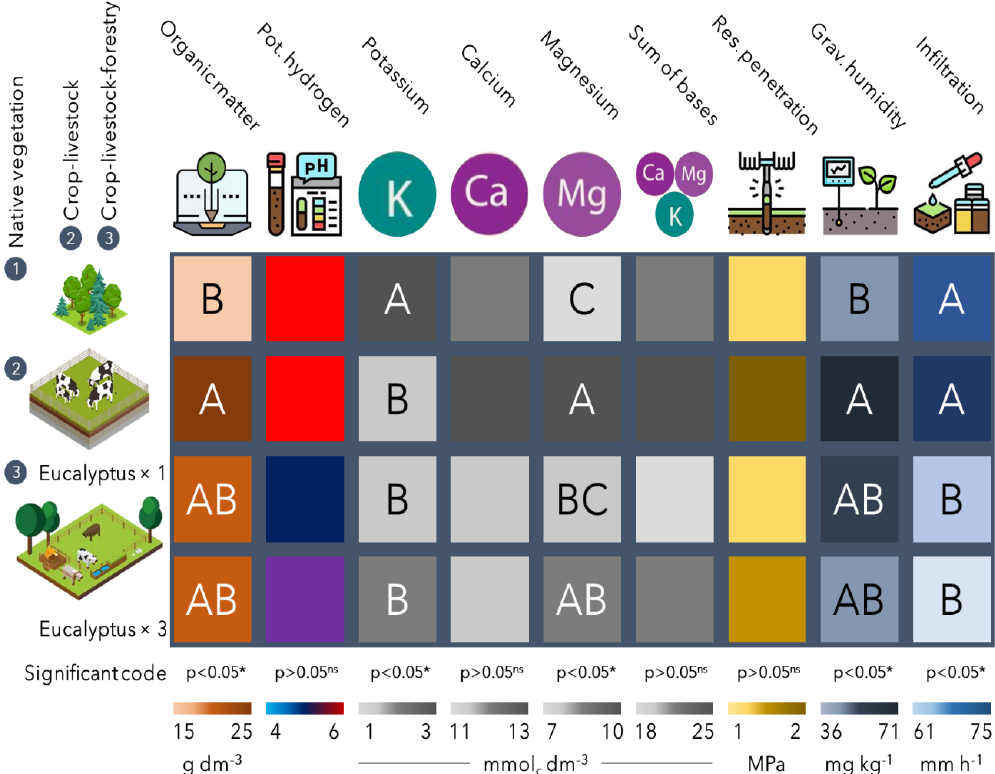
Figure 3. Comparative analysis of integrative systems; cells with the same are not statistically different by post hoc Tukey’s HSD test at p < 0.05. * Cells with the same letter cannot manifest a significant difference by post ‐ hoc Tukey ʹ s HSD test at p < 0.05.